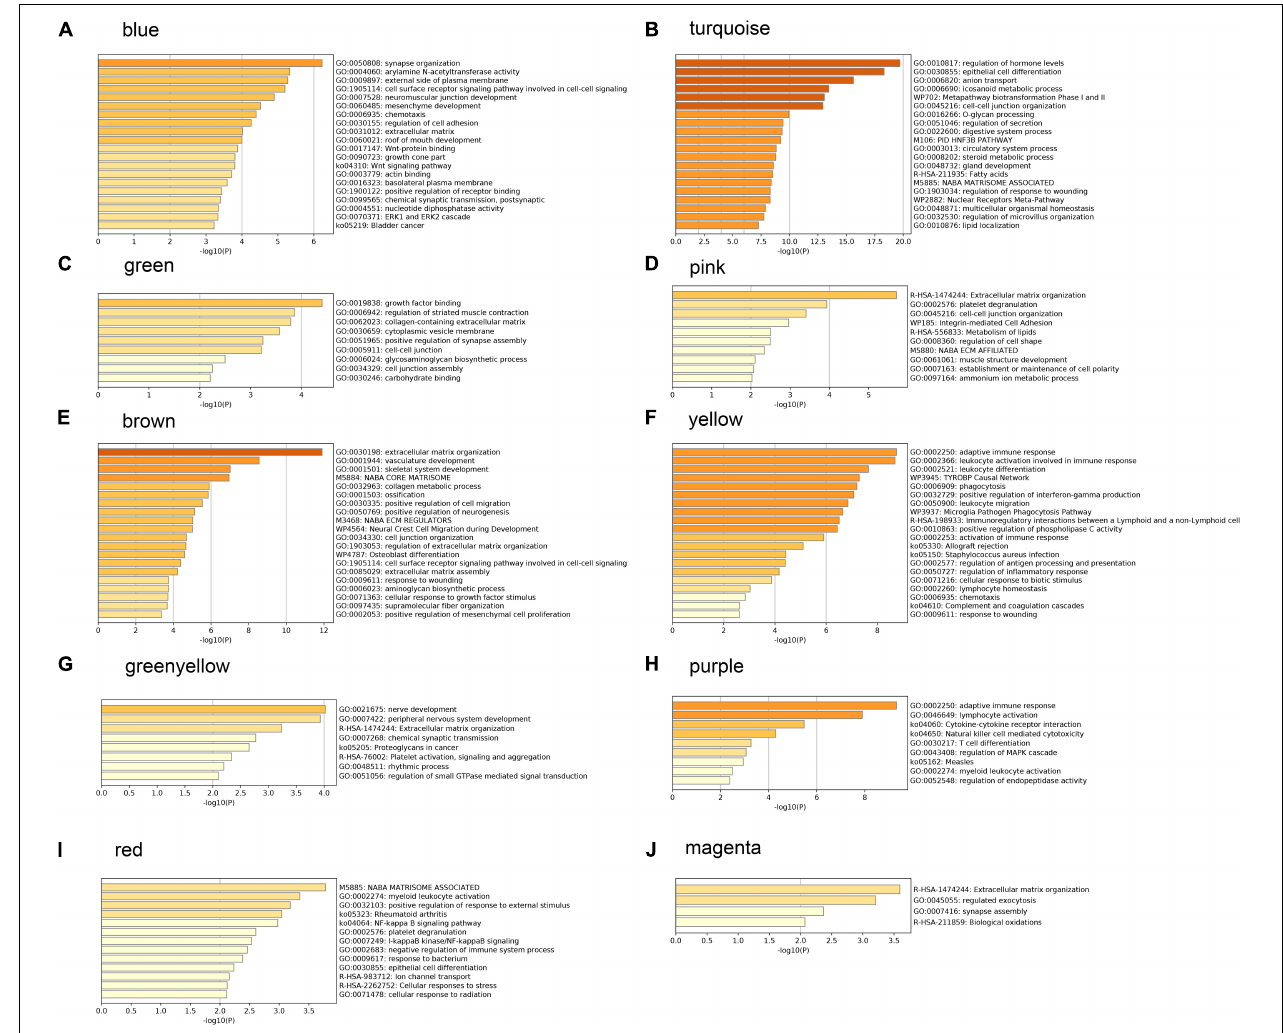
FIGURE 5 | Gene ontology analysis and Kyoto Encyclopedia of Genes and Genomes (KEGG) pathway enrichment results for genes in modules related to histopathological subtypes. (A) The enrichment results for genes in blue module. (B) The enrichment results for genes in turquoise module. (C) The enrichment results for genes in green module. (D) The enrichment results for genes in pink module. (E) The enrichment results for genes in brown module. (F) The enrichment results for genes in yellow module. (G) The enrichment results for genes in greenyellow module. (H) The enrichment results for genes in purple module. (I) The enrichment results for genes in red module. (J) The enrichment results for genes in magenta